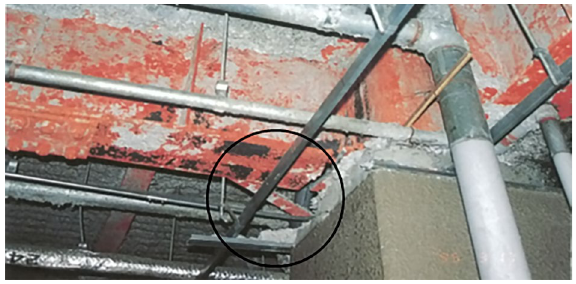
Figure 1. Steel structure damaged by Kobe earthquake in